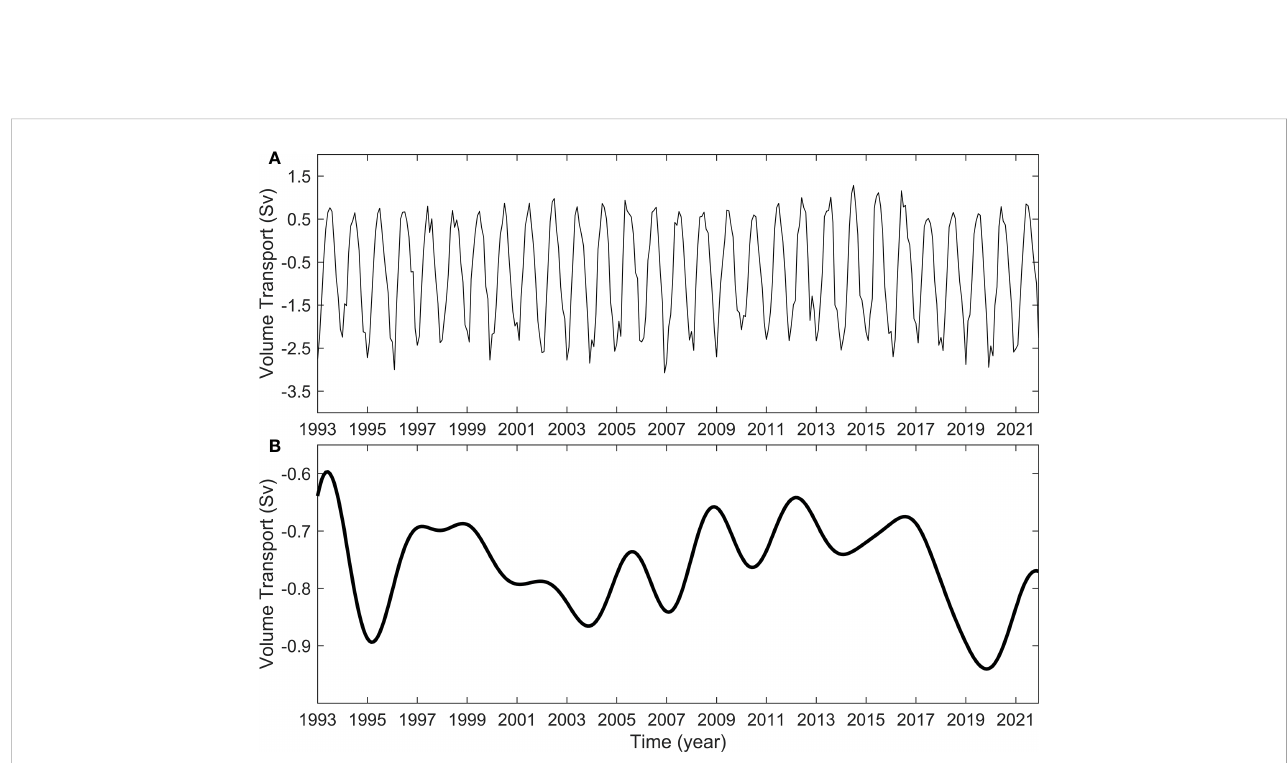
FIGURE 5 (A) Monthly mean volume transport through the KS sections, and (B) the interannual variation obtained using a 3-year low-pass fi lter.